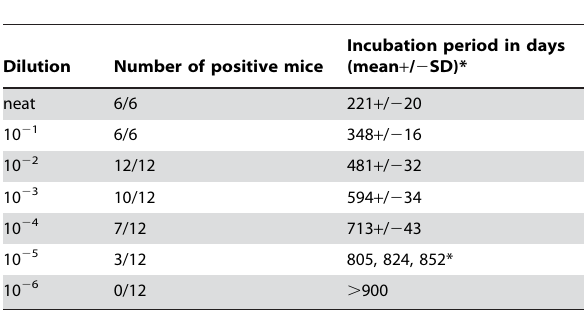
Table 3. End-point titration of a brain homogenate (posterior brainstem- 12.5% weight/volume homogenate) in Tg338 mice.